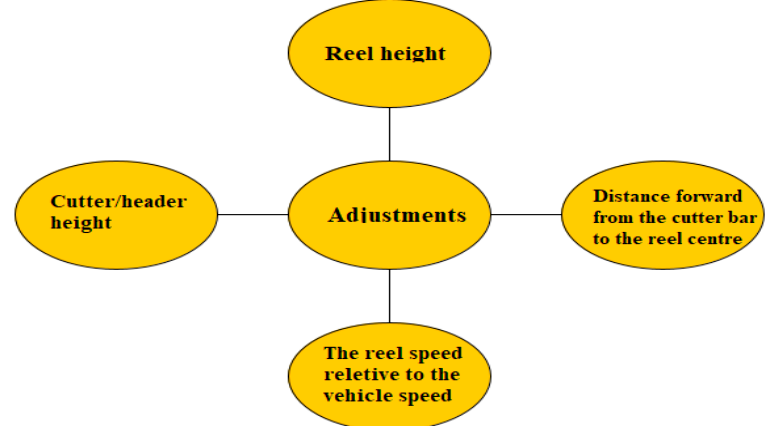
Figure 2. Machine parameters that affect/reduce combine header loss.